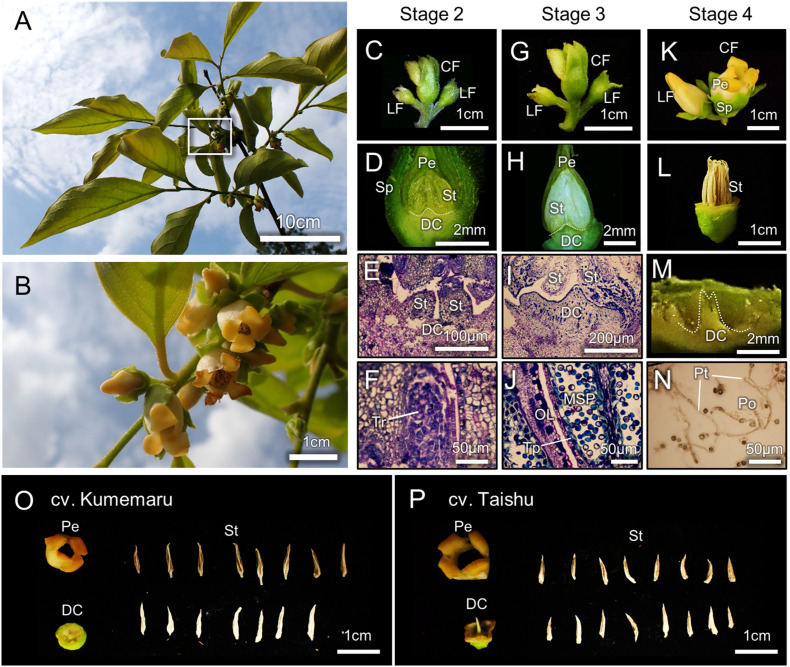
Morphological characterization of male flower development in cv. Kumemaru. (A,B) The appearance of flowering branches in cv. Kumemaru (A), and the closing up of the white box in panel (A), showing cyme-like trifurcated inflorescence (B). (C–N) The developmental processes of male flowers in cv. Kumemaru, in the stages defined according to Yang et al. (2019). In stage 2 (C–F), tetrads (Tr) were formed inside stamens (St) (F). In stage 3 (G–J), microspores (MSP) were developed, while tapetal layers (Tp) have not been degenerated (J). In stage 4 (K–N), flowers opened with mature stamens, producing fertile pollens (Po). Sp, sepal; Pe, petal; DC, deficient carpel; Pt, pollen tube. (O,P) Alignment of male flower components in cv. Kumemaru (O) and monoecious cv. Taishu (P), which included four gamosepalous petals, 1 deficient carpel, and ca 16 stamens.